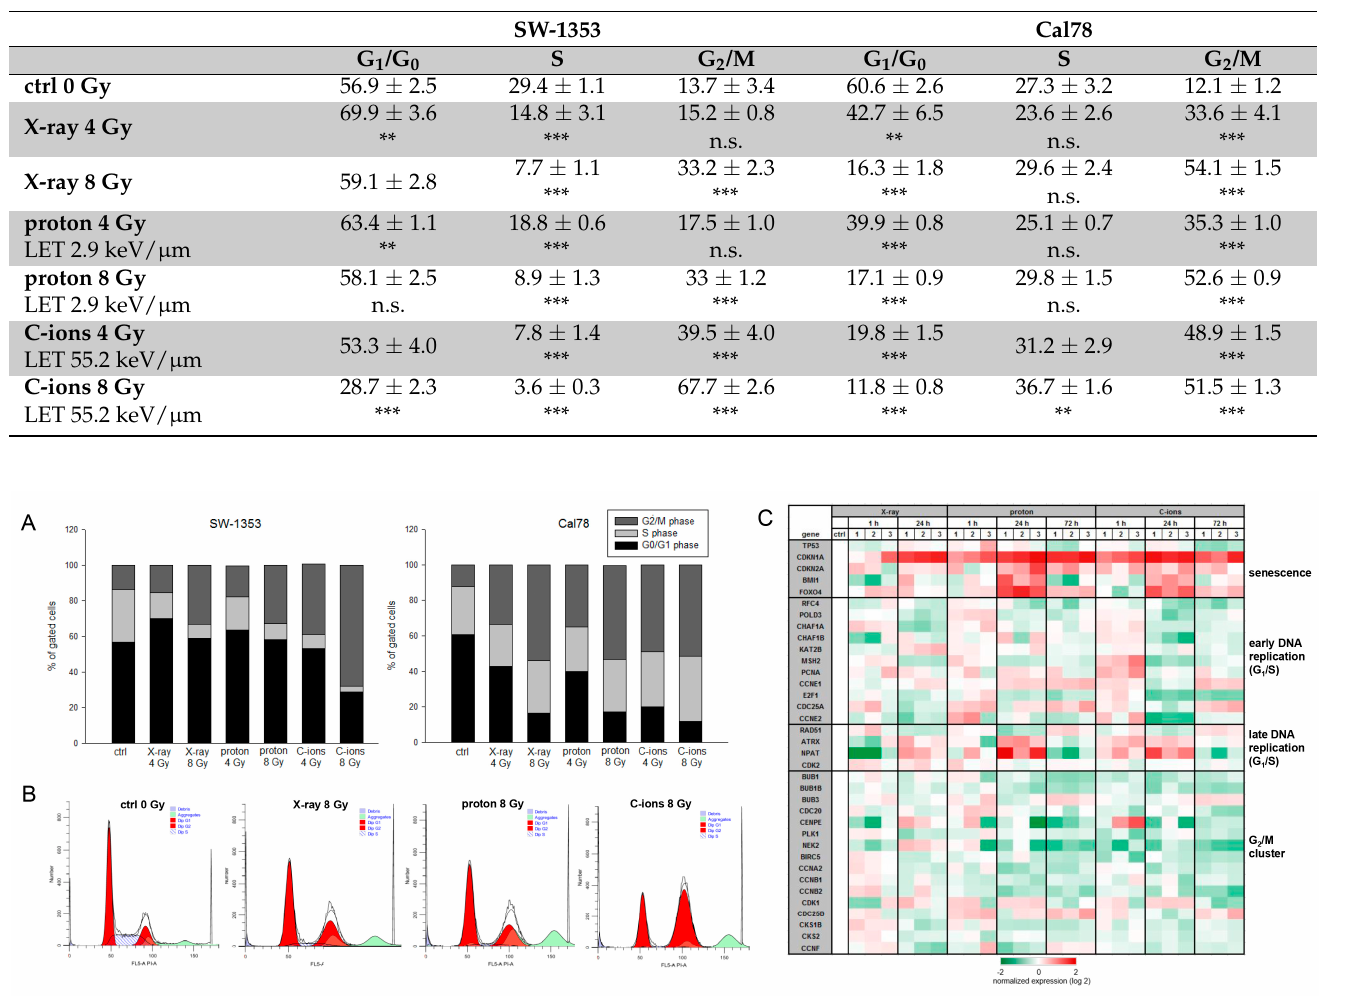
Figure 4. Cell cycle analysis. ( A ) Chondrosarcoma cells were analyzed using flow cytometry 24 h after 4 Gy and 8 Gy X-ray/proton/C-ions IR. The corresponding statistical evaluation shown in stacked bar charts ( n = 4). ( B ) Representative original tracks of non-IR control cells (ctrl) and one measurement of each IR type (8 Gy) are shown. ( C ) Heatmap blot of RNA sequencing data of relevant cell cycle regulator genes presented in log2 fold-change 1 h, 24 h, and 72 h after 4 Gy X-ray/proton/C-ions IR ( n = 4). Table 1. Cell cycle distribution of chondrosarcoma cells 24 h after 4 and 8 Gy photon (X-ray)/pro- ton/C-ions IR ( n = 4; mean ± SD; ** p < 0.01; *** p < 0.001; n.s.: not significant).